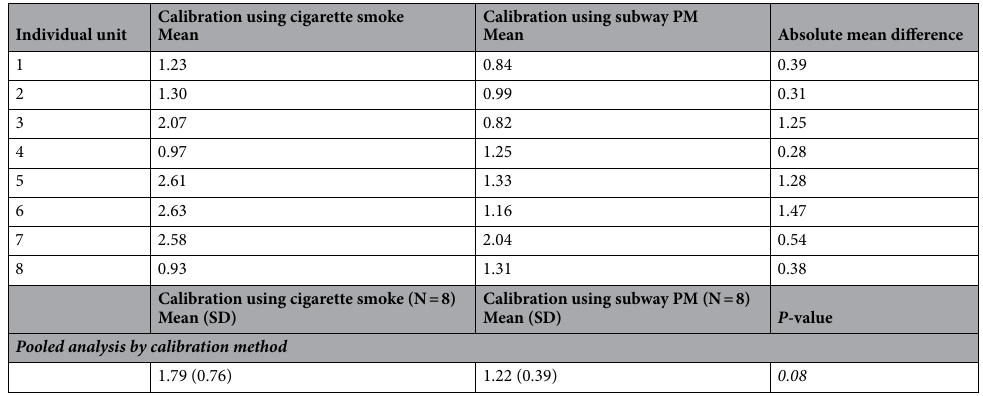
Table 3. A comparison of calibration coefficient mean differences by particulate matter source composition: an individual and pooled analysis across all units at a single timepoint. SD standard deviation.